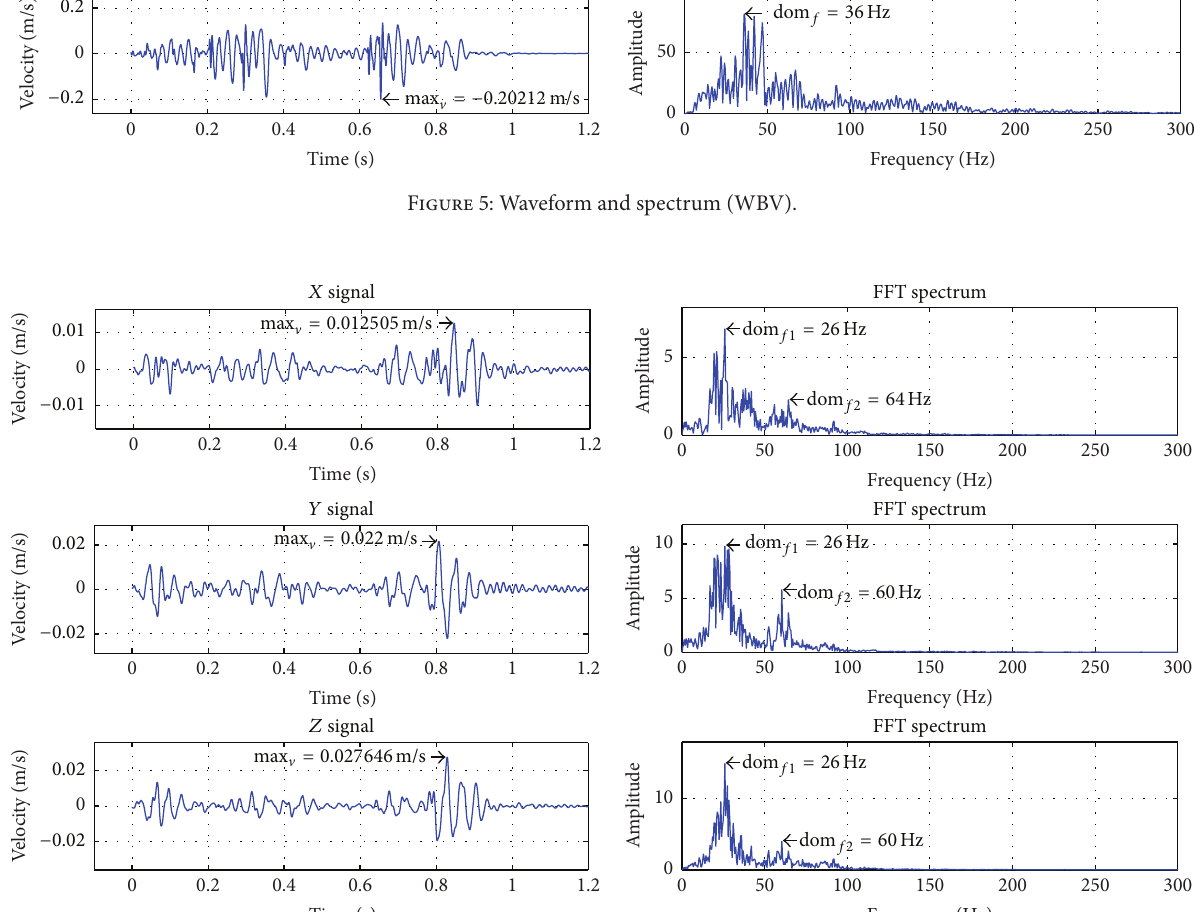
Figure 6: Waveform and spectrum (TC-4850).